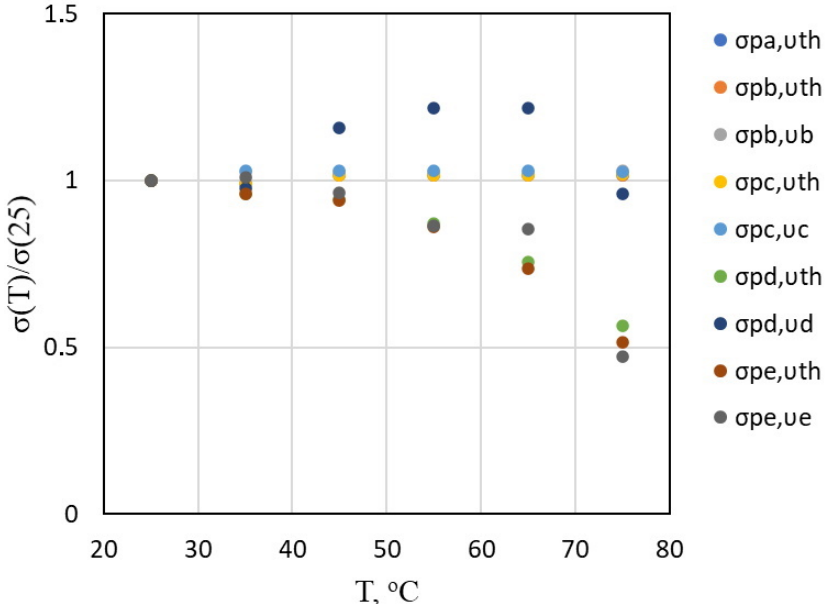
Figure 17. Dependency of cavitation number from temperature in characteristic points. Conic nozzle (from our CFD results).